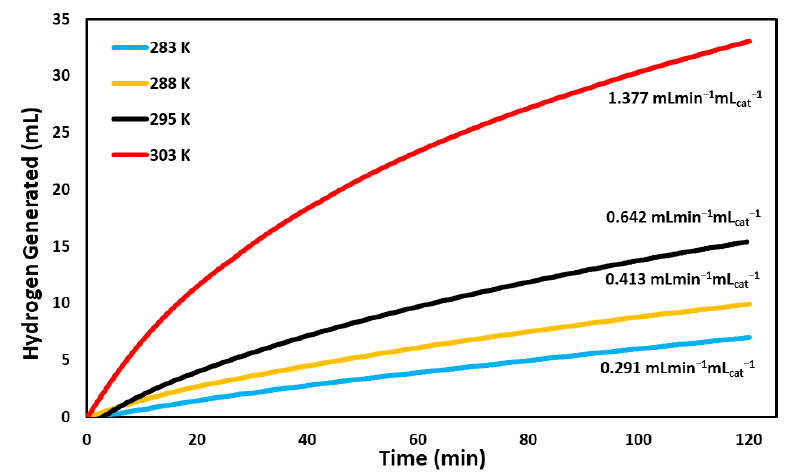
6 of 12 Figure 7. Volume of hydrogen gas generated versus time as catalyzed by the BCD−AuNPs under varied pH conditions (pH 6, 7, 8). The reactions were run at 295 K with 925 µmoles of NaBH 4 for approximately 120 min. 2.4. Catalytic Activity at Varied Temperatures and Activation Energies Under varied temperatures, BCD-AuNPs produced hydrogen the fastest at 303 K at a rate of 1.377 mL min −1 mL cat−1 (Figure 8). Performance followed 303 K with 295 K, 288 K, and 283 K, producing rates of 0.642 mL min −1 mL cat−1 , 0.413 mL min −1 mL cat−1 , and 0.291 mL min −1 mL cat−1 , respectively (Figure 8). A clear trend was seen where the rate of hydrogen generation increased with increasing temperatures. According to le Chatelier’s principle,